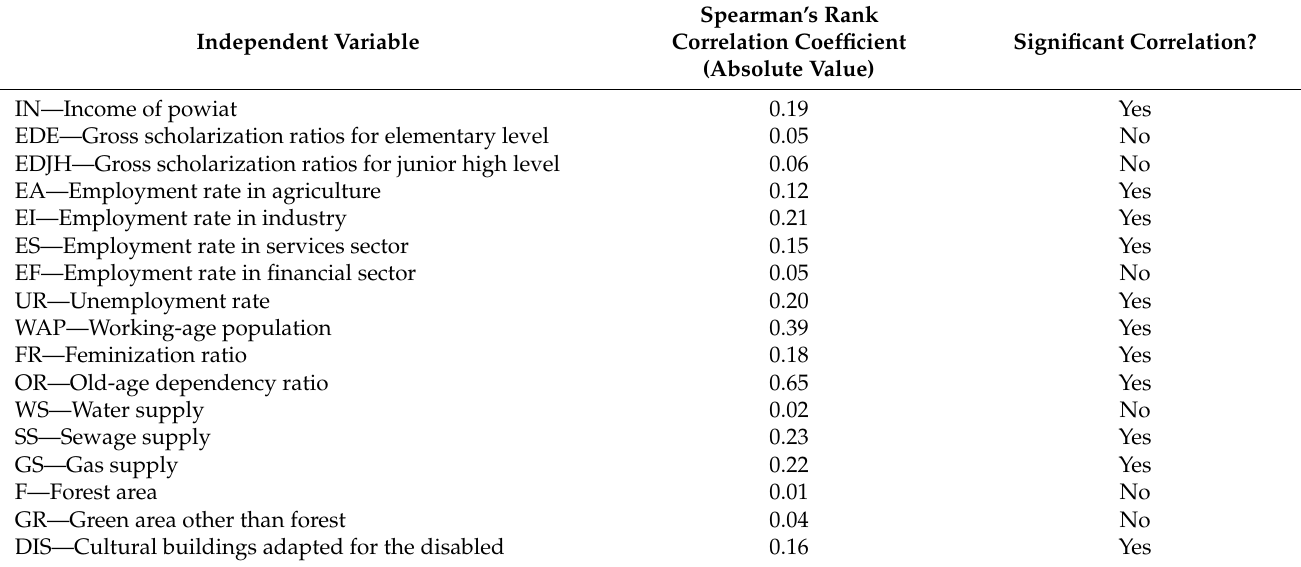
Table 5. Correlations between independent variables and the mortality rate.